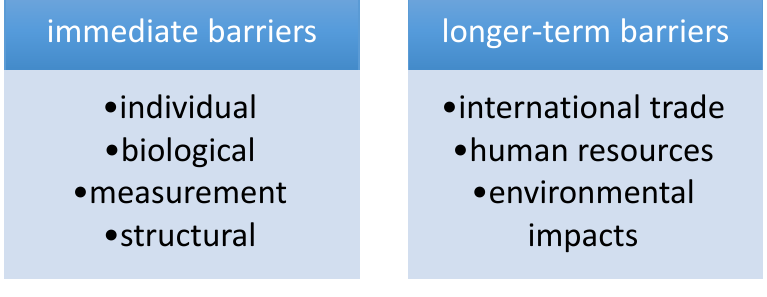
Figure 1. Immediate and longer-term barriers to